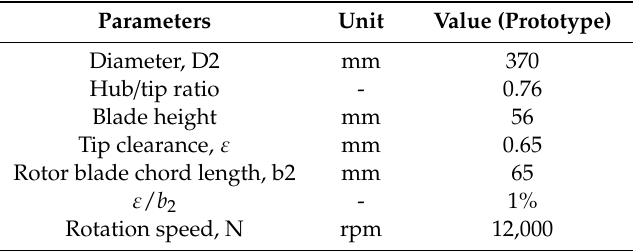
Table 1. Design parameters of the prototype.